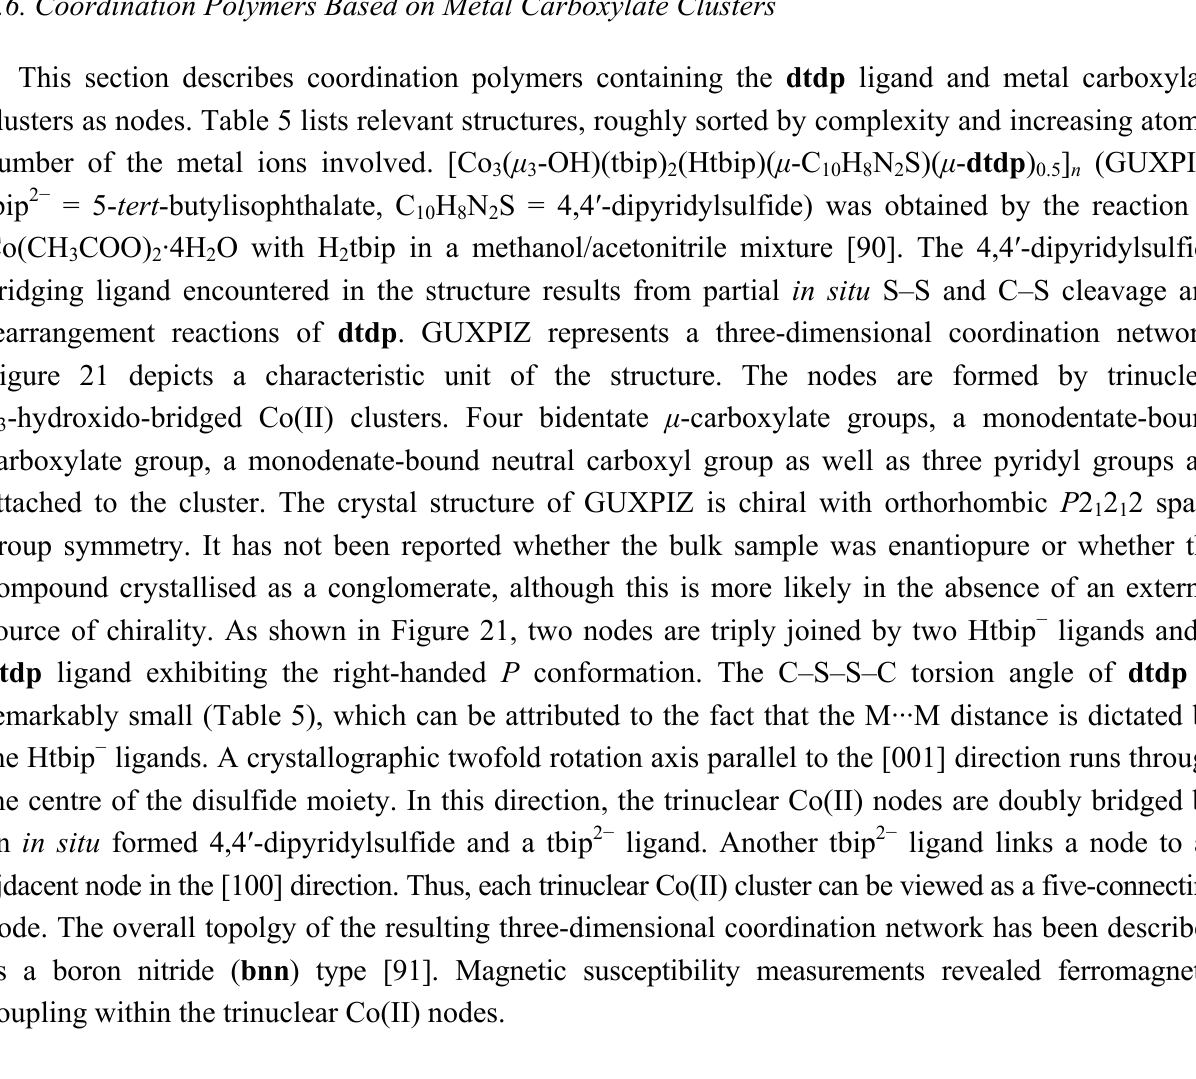
Figure 20. Coordination network with (4,4) net topology in [CdCl